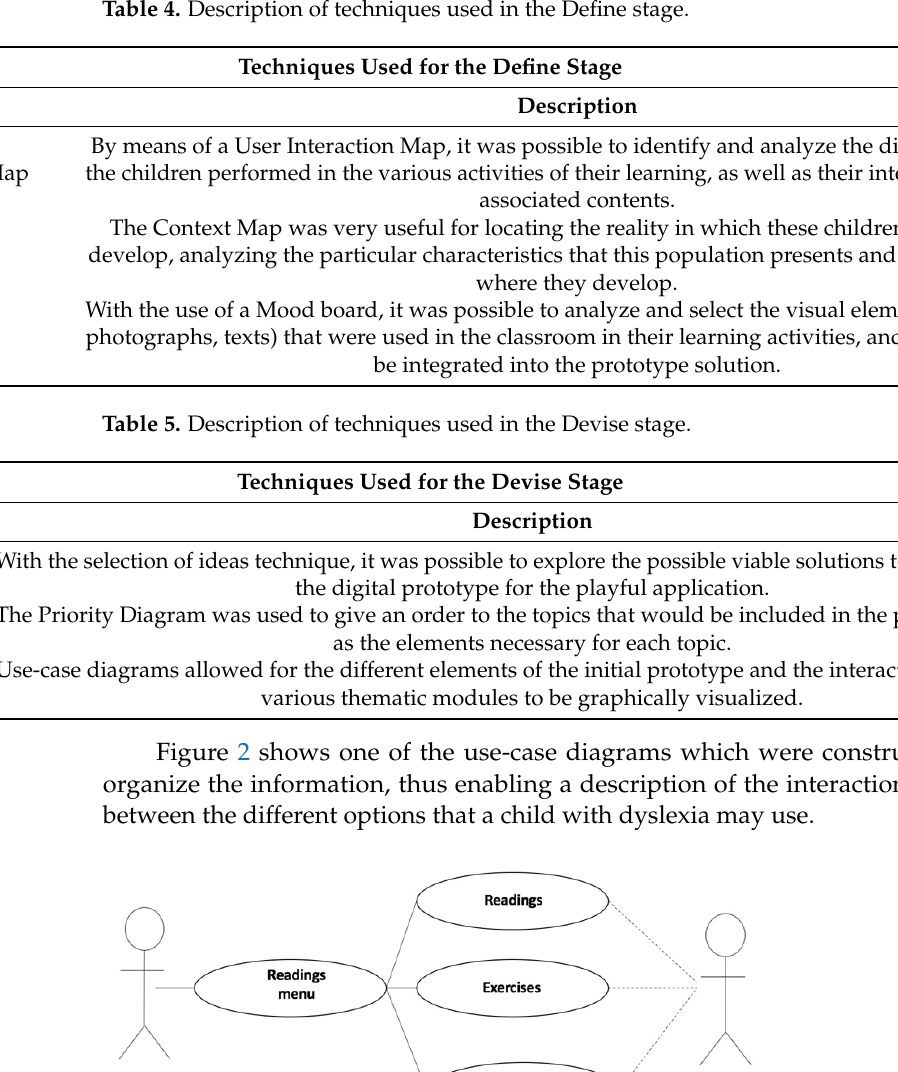
Table 4. Description of techniques used in the Define stage.